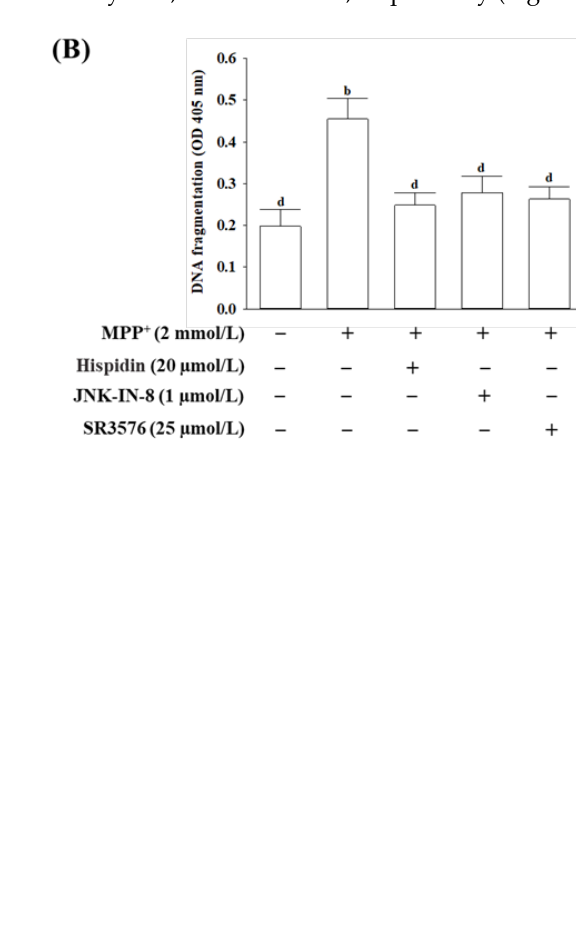
Figure 5. Hispidin reduces caspase-mediated apoptosis induced by MPP + . MS23.5 cells were pretreated with hispidin (20 µ mol/L), JNK-IN-8 (1 µ mol/L), or SR3576 (25 µ mol/L) for 1 h and then exposed to 2 mmol/L MPP + for another 24 h. ( A ) Caspase-9, caspase-3, and PARP activities were assessed using commercial colorimetric assay kits. ( B ) The extent of apoptosis was quantified using the ELISA kit to detect DNA fragments associated with cytoplasmic histones. The results are shown as the mean ± SD of five independent experiments ( n = 5) performed in triplicate. a p < 0.05 and b p < 0.01 compared to the untreated control group. c p < 0.05 and d p < 0.01 compared to the untreated MPP + group.